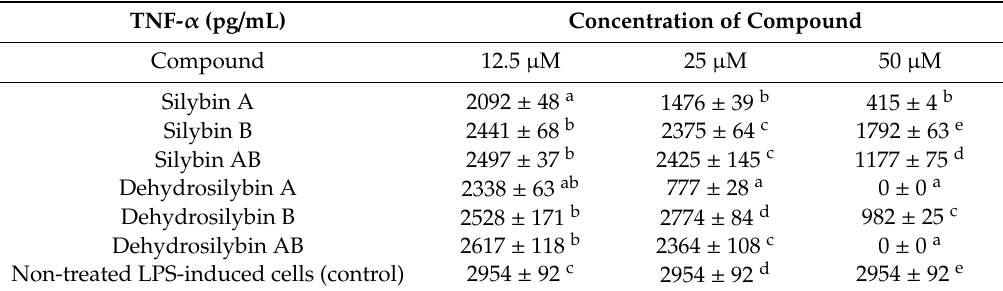
Table 4. The e ff ect of various concentrations of silybins and dehydrosilybins (12.5, 25, 50 µ M) on the release of pro-inflammatory cytokine TNF- α by LPS-induced macrophages. Positive control represents the cells challenged with LPS and without pre-treatment of tested